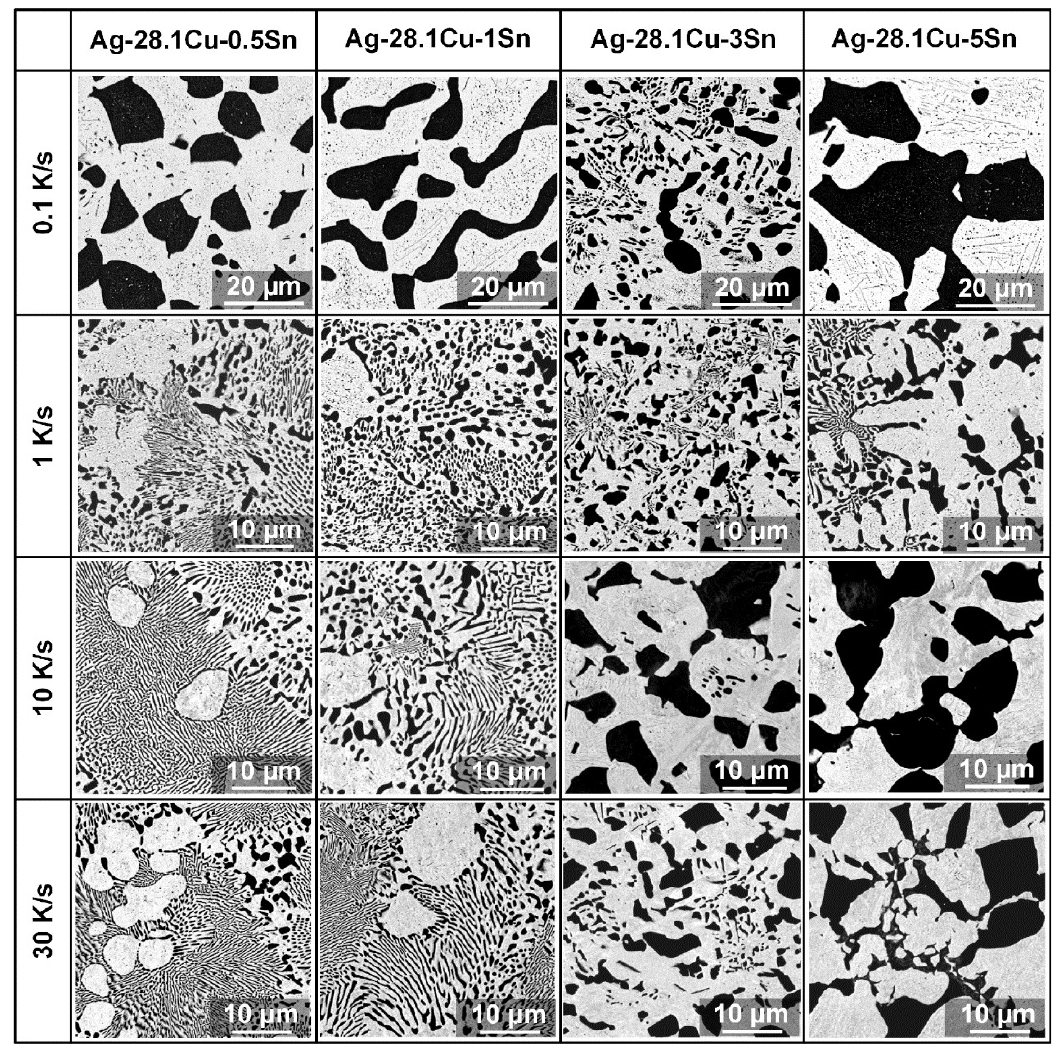
Figure 6. Microstructural evolution of the Ag-Cu eutectic alloys solidified at different cooling rates.